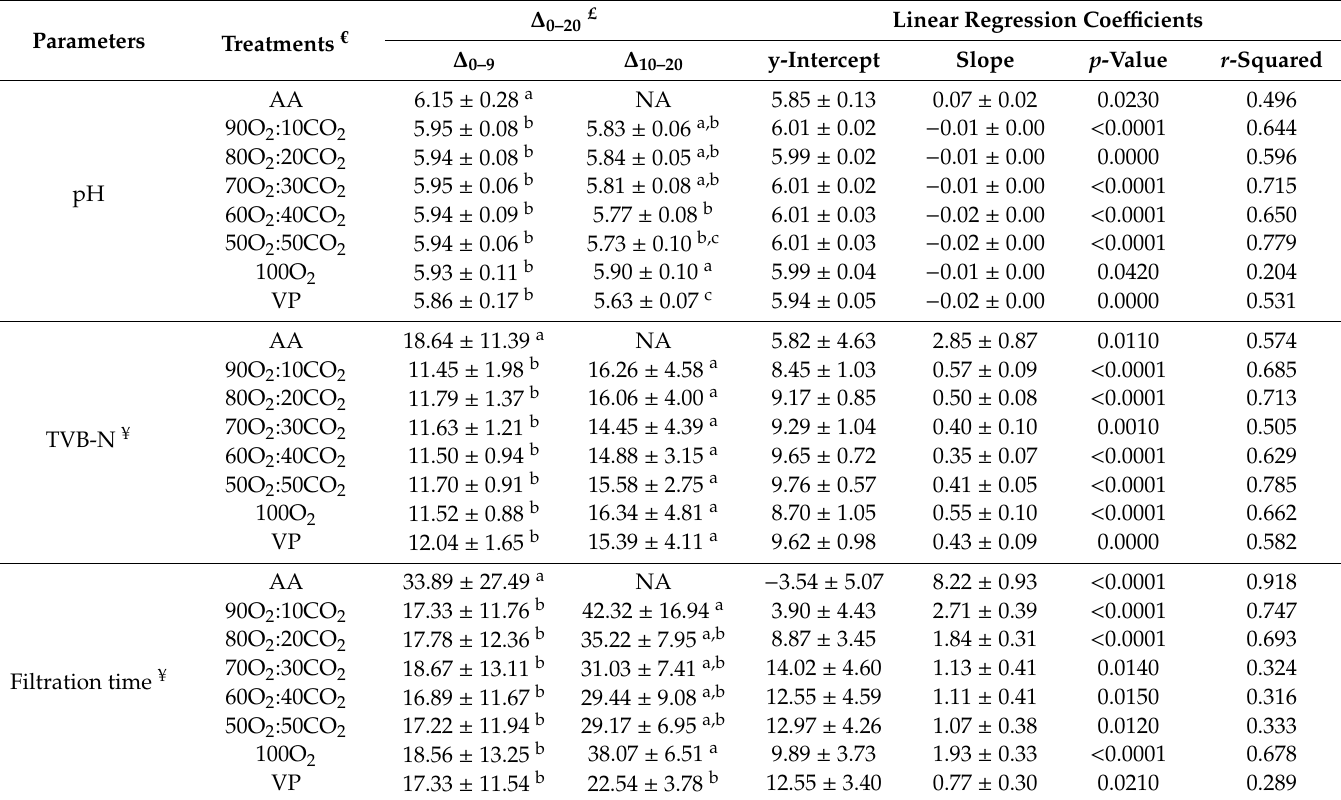
Table 1. Physicochemical parameters of the ground beef treated with di ff erent packaging systems stored at 2 ◦ C for 20 days.